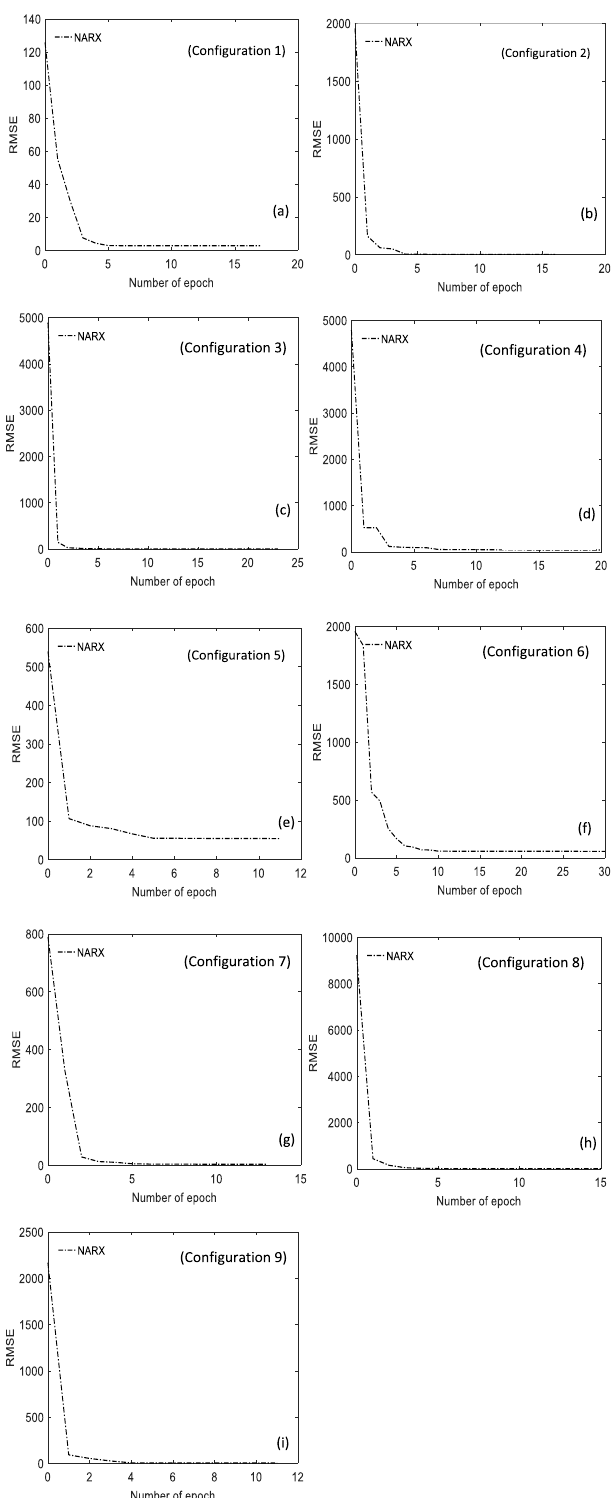
Fig. 12 Number of epoch versus fitness value (RMSE) for all